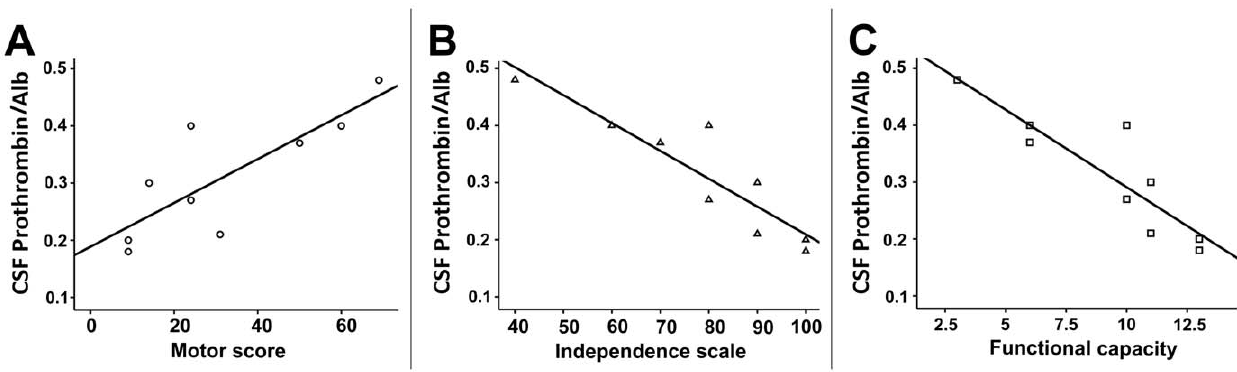
Figure 5. Linear regression of prothrombin/Alb to motor score, independence scale, and function capacity of UHDRS, respectively. The ratio of prothrombin/Alb was significantly correlated to subscales of UHDRS, with a positive correlation to motor score (A, r =0.810, p =0.008) and a negative correlation to independence scale (B, r = 2 0.908, p , 0.001) and functional capacity (C, r = 2 0.891, p =0.001).